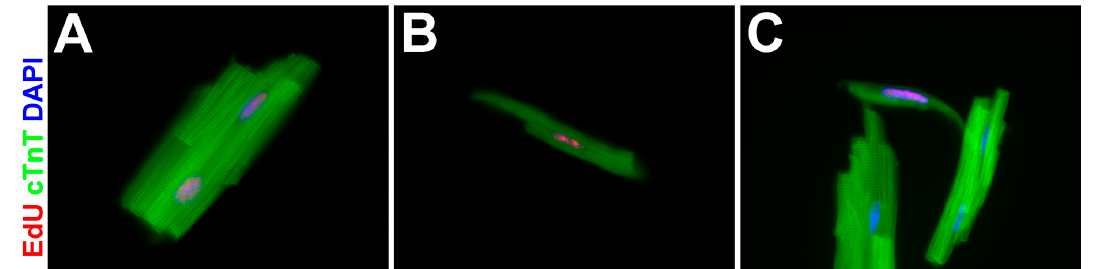
Figure 6. Asxl2 − / − EdU + cardiomyocytes display a range of size, morphology, and nucleation status. Cardiomyocytes were isolated and stained for EdU, cTnT, and DAPI. Representative images highlighting differences among Asxl2 − / − EdU + cardiomyocytes shown are ( A ) binuclear and rod-shaped with length comparable to EdU − cardiomyocytes; ( B ) mononuclear and rod-shaped with normal length; and ( C ) mononuclear, spindle-shaped, and short.